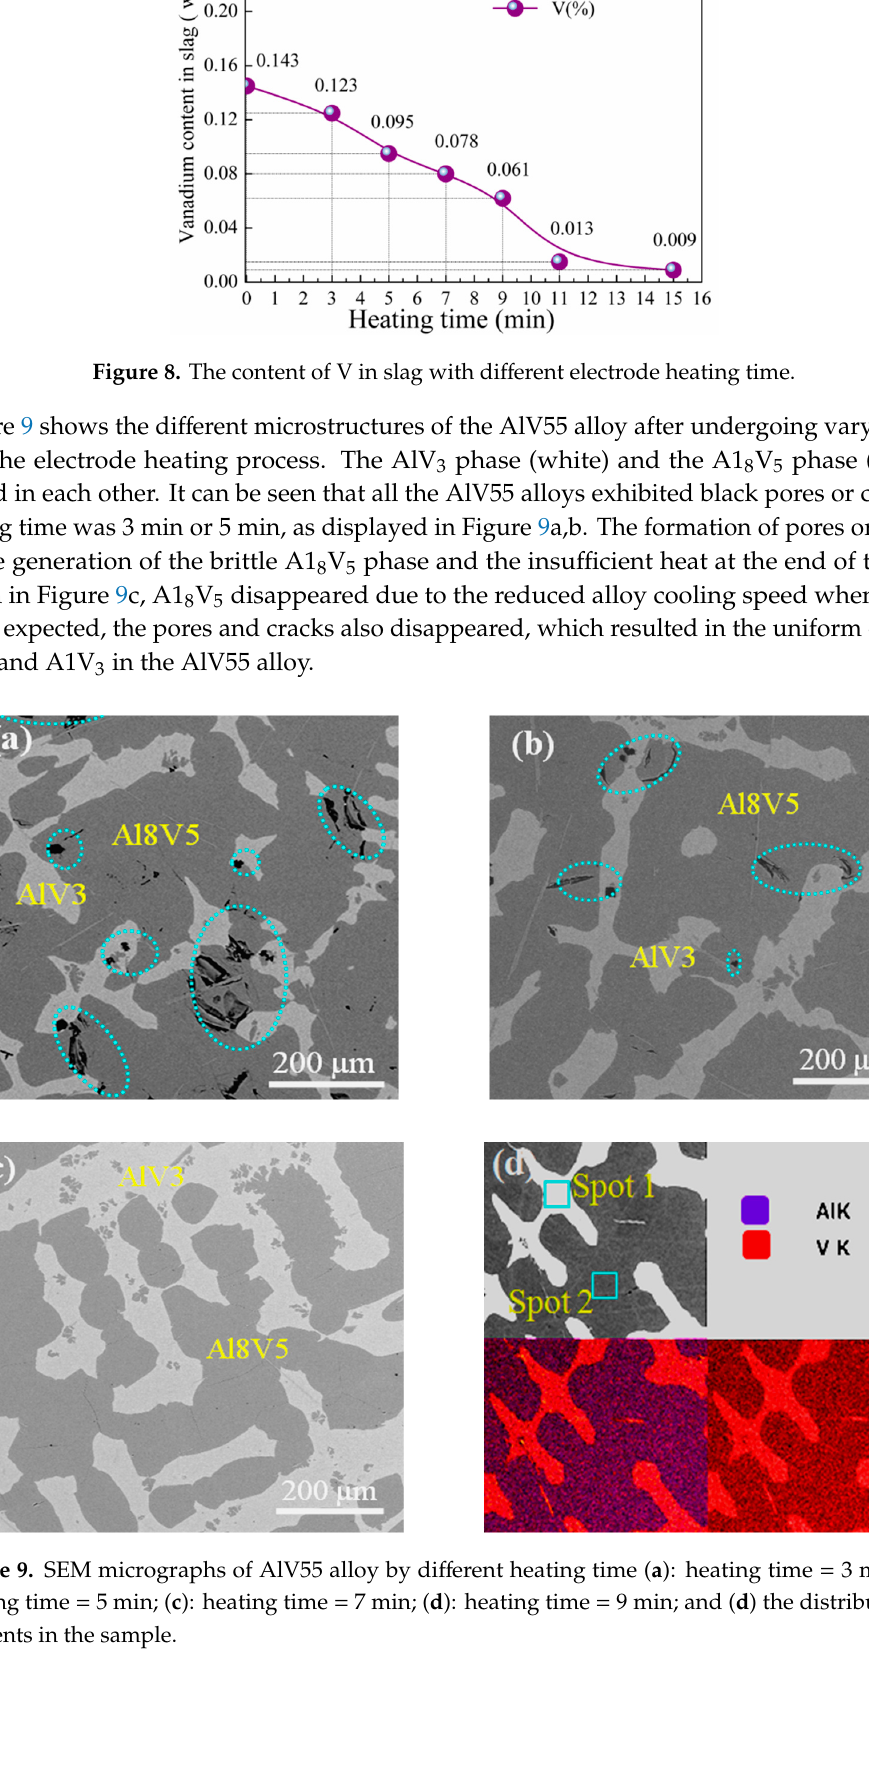
Figure 7. The composition of the product with different heating time ( a ): distribution of impurities in the sample; ( b ): V content in the sample.